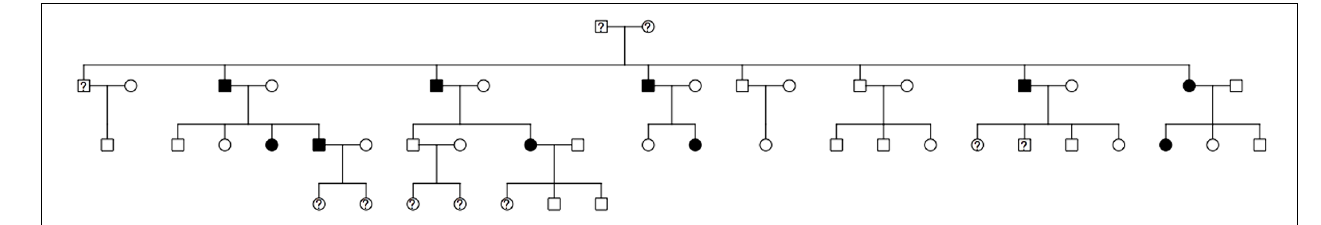
FIGURE 2 | Structure of the analyzed pedigree (filled, affected; empty, unaffected; ?, unknown phenotype and genotype).